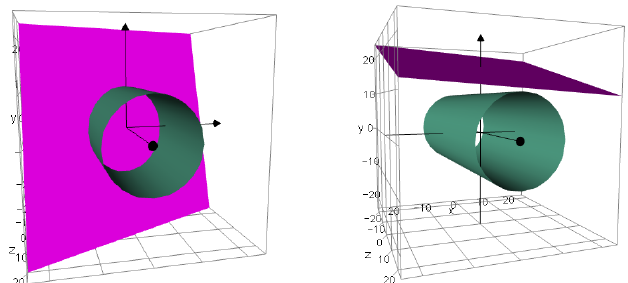
Figure 2. Visualization of two exemplary orientations of the recorded decay plane (violet) with respect to the cylindrical annihilation chamber (green). Left: in the case of a genuine o-Ps → 3 γ decay occurring in the positronium production medium located in the cylinder wall, the point of closest approach of the plane to detector center is small. Right: in case of a decay plane resulting from an accidental 3-photon coincidence, the decay plane may be distant from the center.